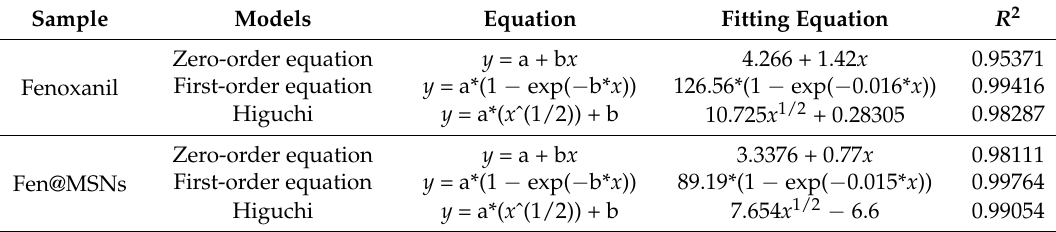
Figure 6. Release rates of Fenoxanil from Fen@MSNs at room temperature. Table 1. Mathematical models of Fenoxanil release from Fenoxanil and Fen@MSN solutions.